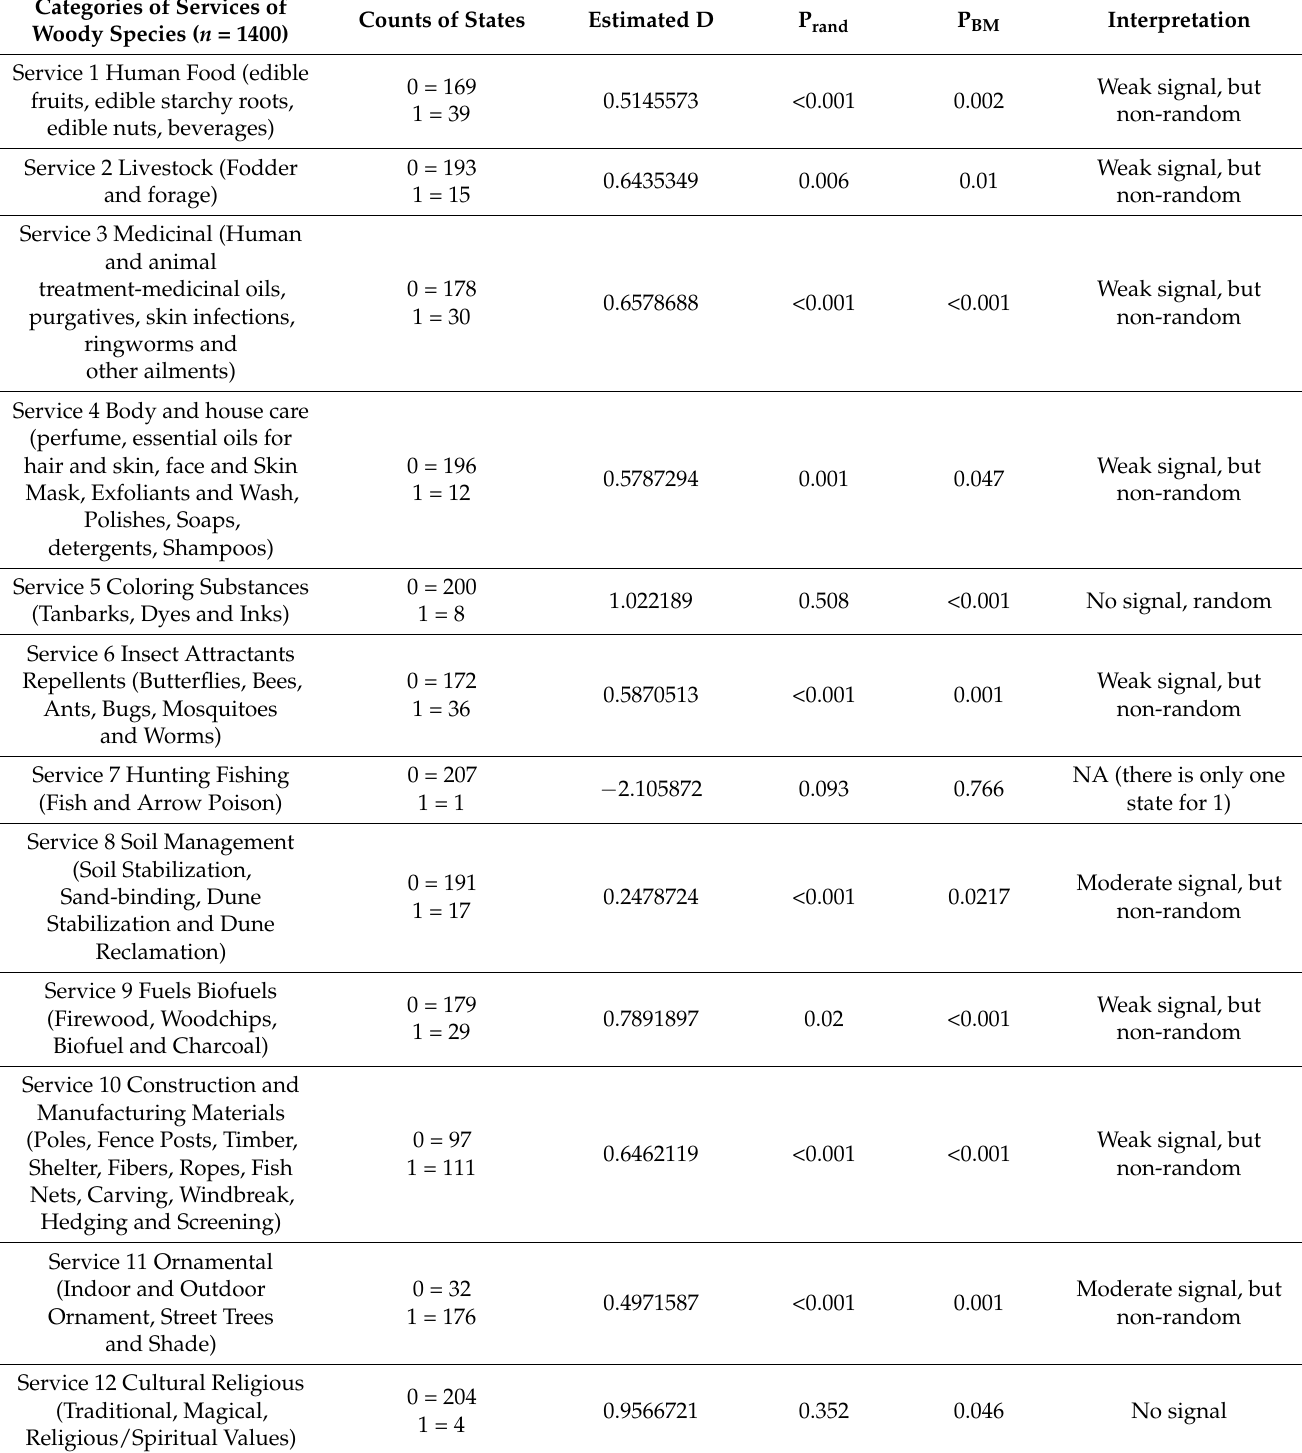
Table 1. Results of phylogenetic signal test in the services provided by alien plant species using D statistic. The p values for tests of significance were reported as P BM (giving the result of testing whether D was significantly different from 0) and Prand (giving the result of testing whether D was significantly different from 1). A weak-to-moderate significant signal was detected in 9 out of 12